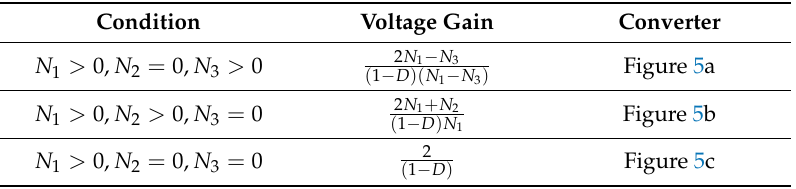
Table 1. Derived